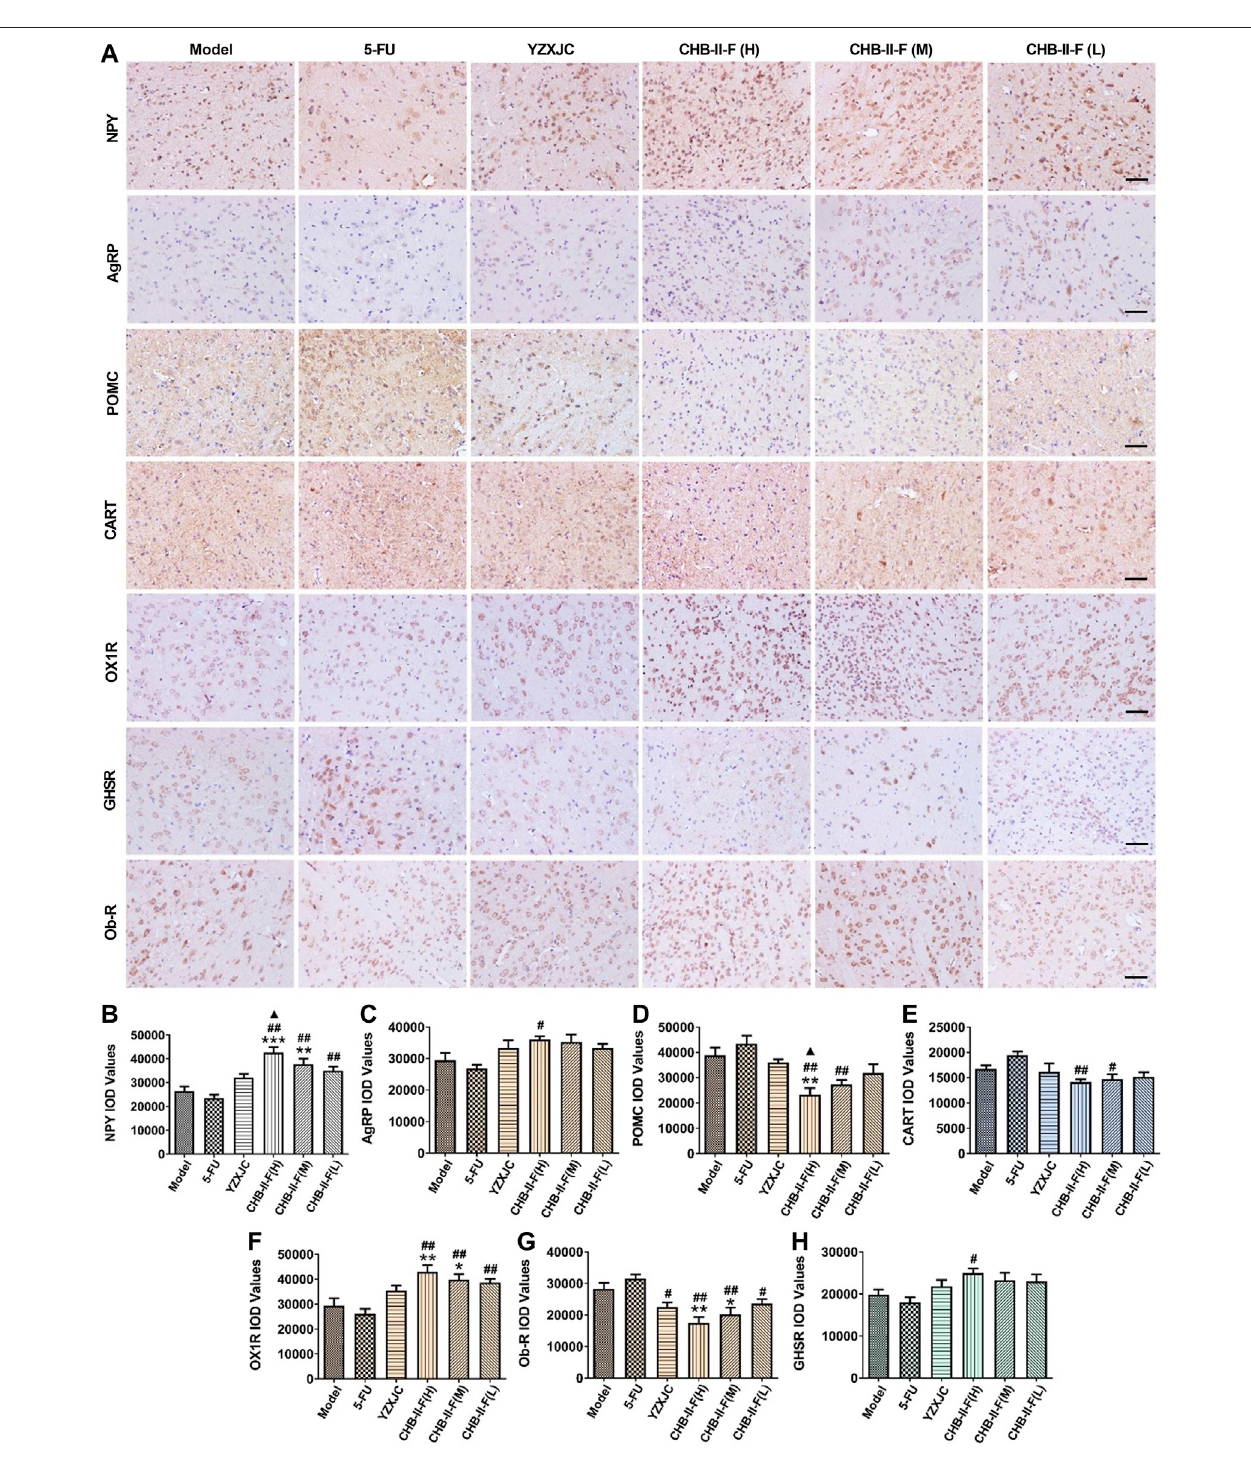
FIGURE 7 | Effects of CHB-II-F on protein expression of NPY, AgRP, POMC, CART, OX1R, Ob-R, and GHSR in the hypothalamus of the transplanted H 22 hepatocellular carcinoma model mice receiving chemotherapy detected by immunohistochemistry ( x ± s , n (cid:2) 6). (A) Immunohistochemical pictures of NPY, AgRP, POMC,CART,OX1R,Ob-R,andGHSRproteinexpressioninhypothalamus( × 400,scalebar (cid:2) 200 μ m). (B) NPYIODvaluesindifferentgroups. (C) AgRPIODvaluesin differentgroups. (D) POMCIODvaluesindifferentgroups. (E) CARTIODvaluesindifferentgroups. (F) OX1RIODvaluesindifferentgroups. (G) Ob-RIODvaluesin differentgroups. (H) GHSRIODvaluesindifferentgroups.Statisticalanalysis:* p < 0.05,** p < 0.01,*** p < 0.001comparedwiththemodel(saline)group. # p < 0.05, ## p < 0.01 compared with the 5-FU group. ▲ p < 0.05 compared with the YZXJC group.